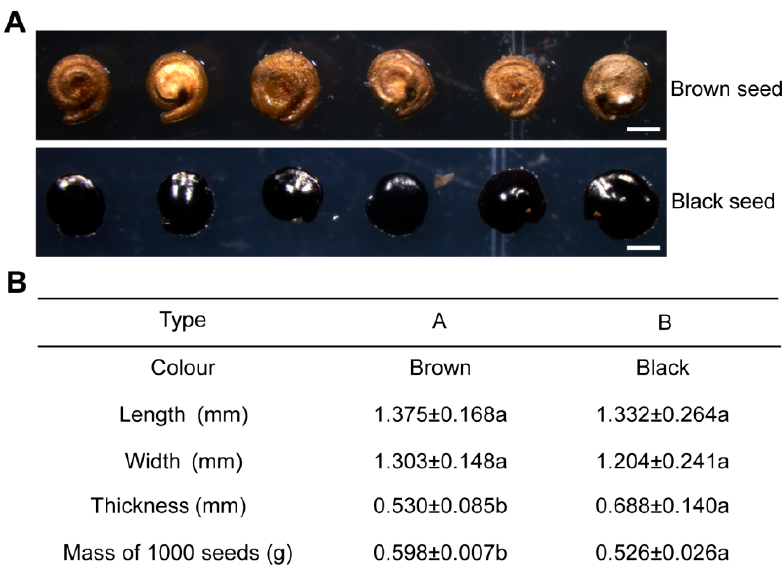
Figure 1. Morphological characteristics of dimorphic seeds of S. liaotungensis . ( A ) Microscopic images of the dimorphic seeds. Bars = 1 mm. ( B ) Comparison of length, width, thickness, and 1000-seed mass of dimorphic seeds. There were 50 seeds counted for each replicate. Different letters show significant differences ( t -test, p < 0.05).